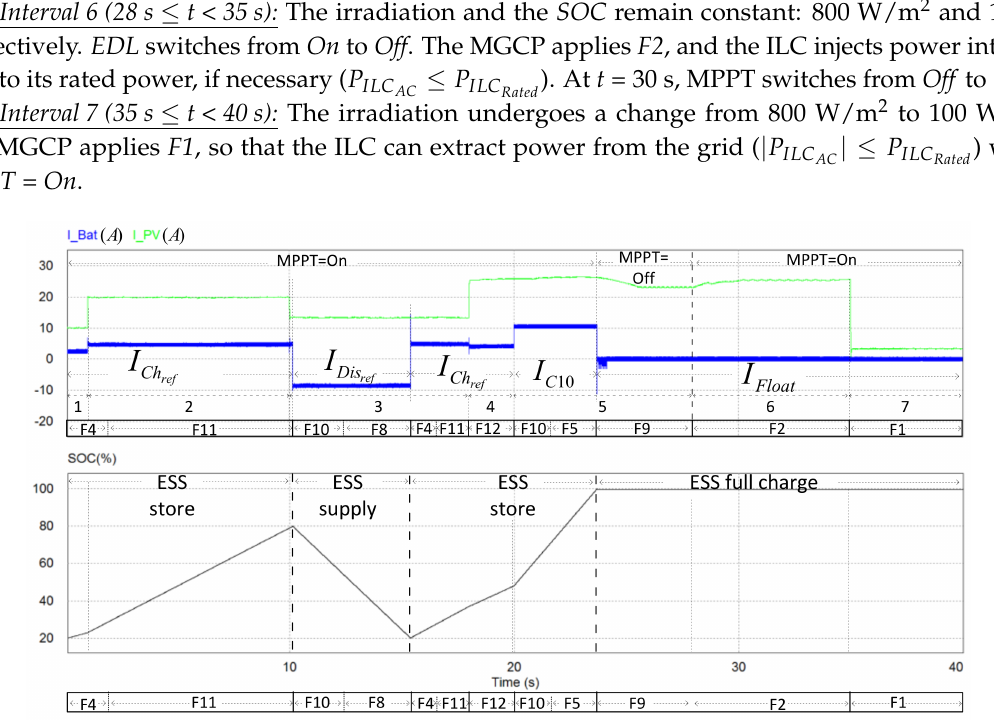
Figure 6. Simulation waveforms, I Bat , I PV = I PV1 + I PV2 the SOC over